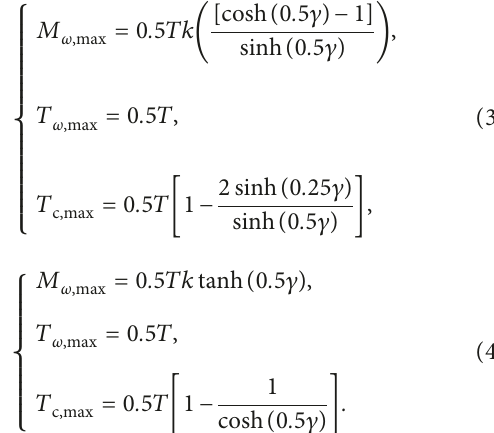
Figure 2: Variation tendency of the maximum internal forces with the increasing of span length. “FS” and “SS” mean “fixed-fixed supported” and “simply supported,”